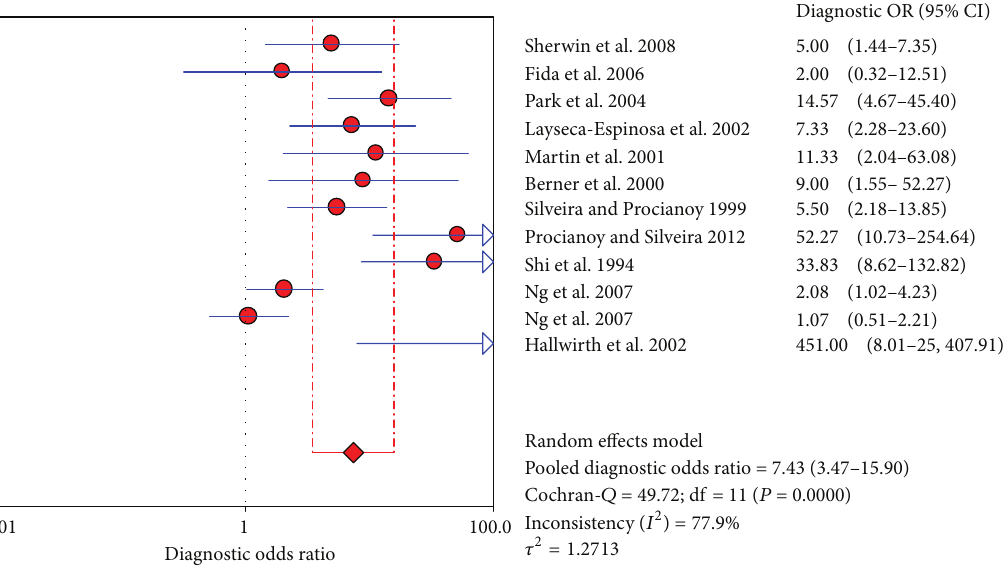
Figure 3: Forest plot for diagnostic OR of the TNF- 𝛼 test to diagnose neonatal sepsis at the EONS.